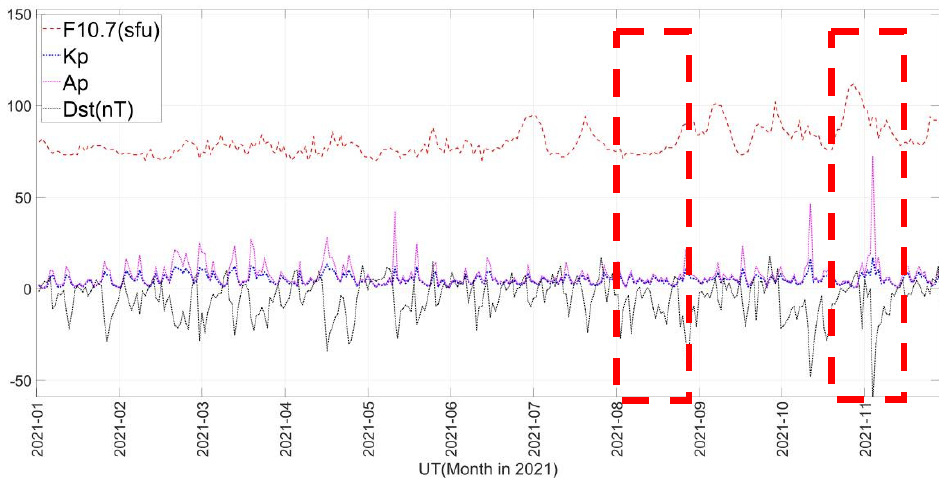
Figure 2. Amplitude of solar and geomagnetic activity.